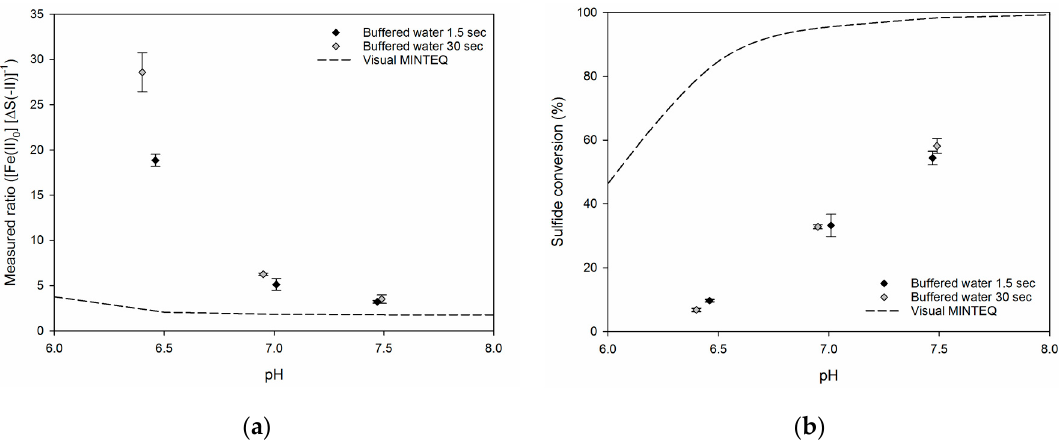
Figure 3. ( a ) The stoichiometric ratio of sulfide precipitation using ferrous iron in buffered water as a function of pH. ( b ) Sulfide conversion in buffered water as a function of pH. Each point represents the average of the three individual measurements and error bars indicate their standard